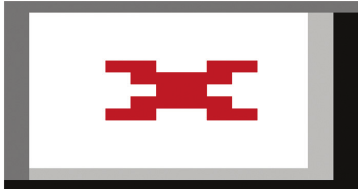
Figure 2: Framework of